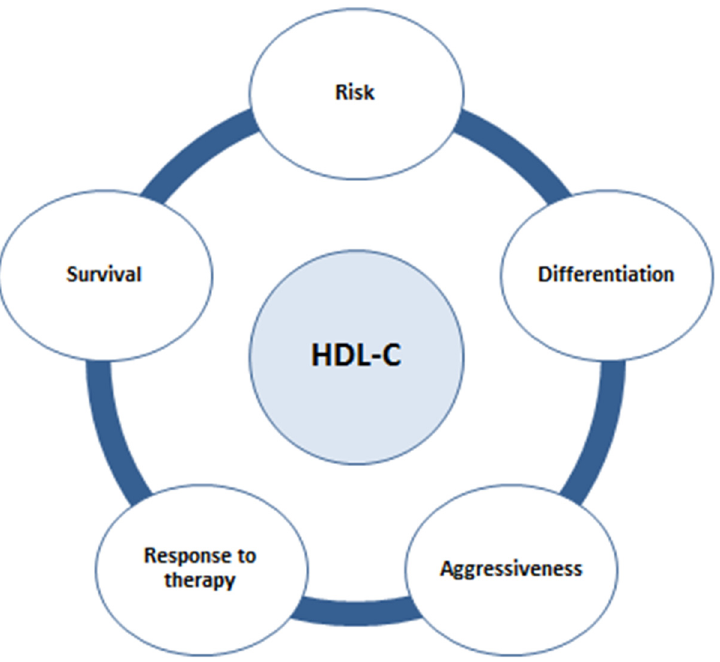
Figure 1. The relationship between high-density lipoprotein cholesterol (HDL-C) levels and colorectal cancer (CRC).